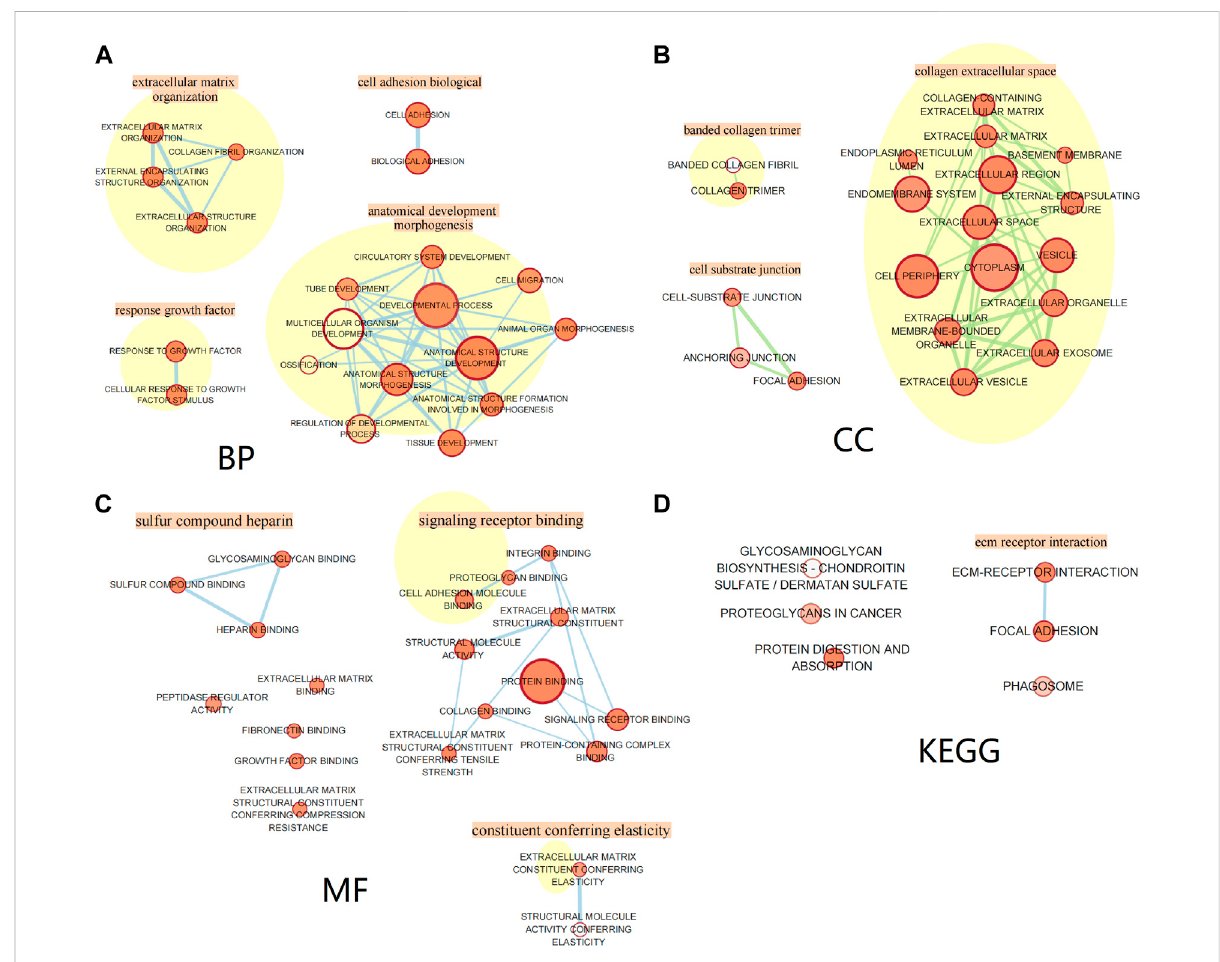
FIGURE 8 GeneOntologyandpathwayenrichmentanalysisofthebluemodulegenes. (A) Biologicalprocessanalysis. (B) Cellularcomponentanalysis. (C) Molecular function analysis. (D) KEGG pathway